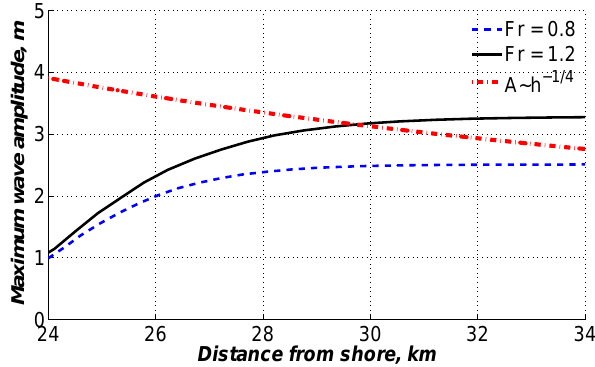
Fig. 10. Variations of the maximum amplitude of tsunami waves during its propagation along the quartic bottom profile h ∼ x 4 for positive waves propagating